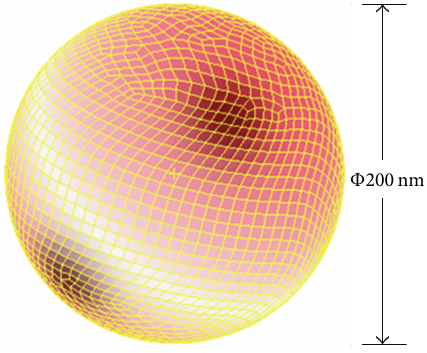
Figure 2: The sketch of 3D cranial cavity and grid division.